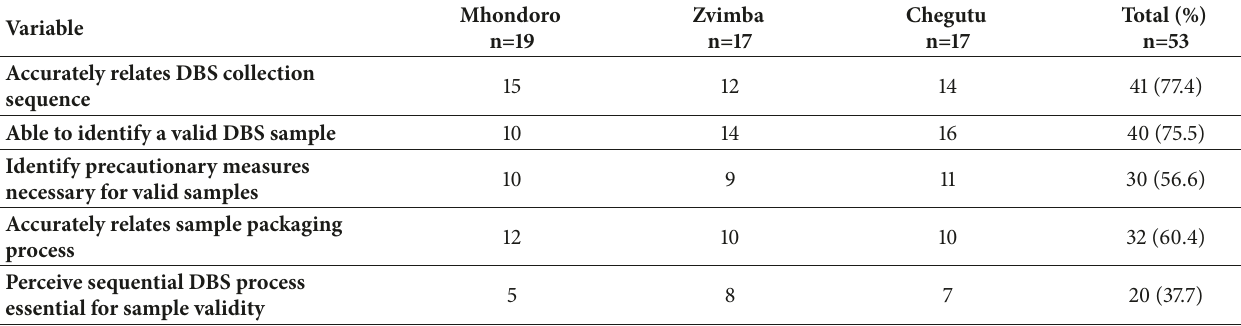
Table 3: Expertise of Personnel Responsible for Collection of DBS samples for EID for Mhondoro, Zvimba, and Chegutu Districts, 2016. Va r iable